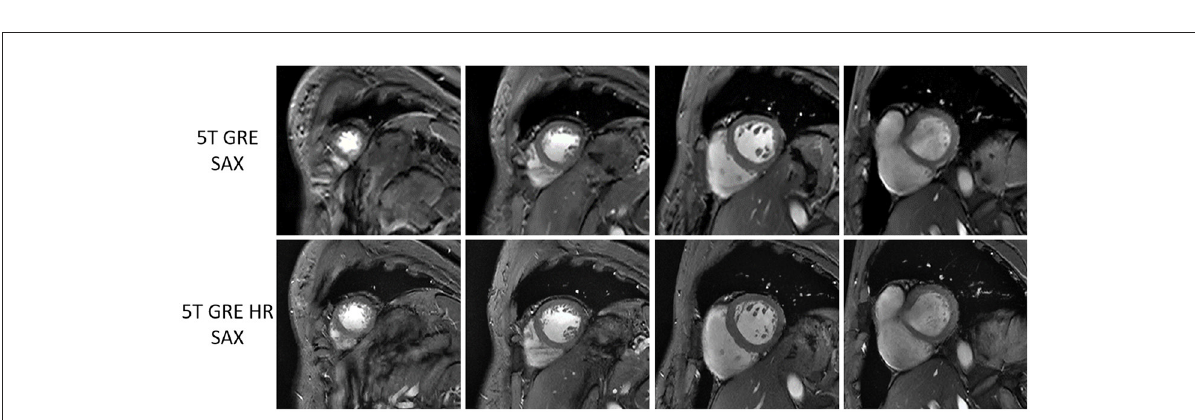
FIGURE3 Multi-slice short-axis GRE images at 5T of one volunteer, comparing between routine resolution (top row) and high resolution (bottom row).